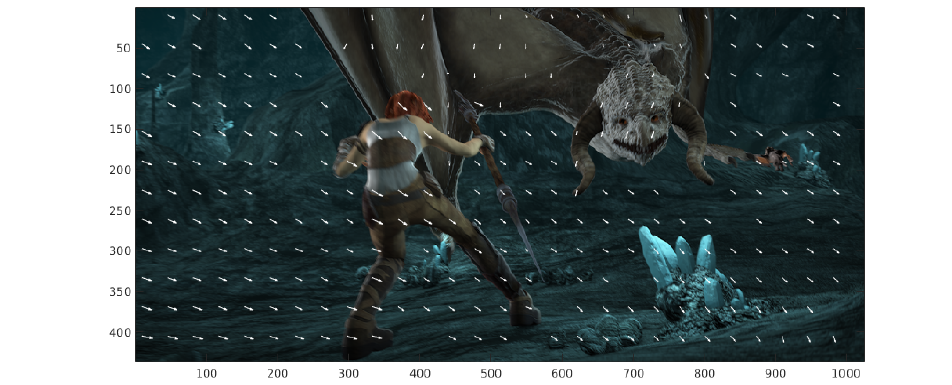
Figure 2. Correspondences of patches located uniformly in the reference